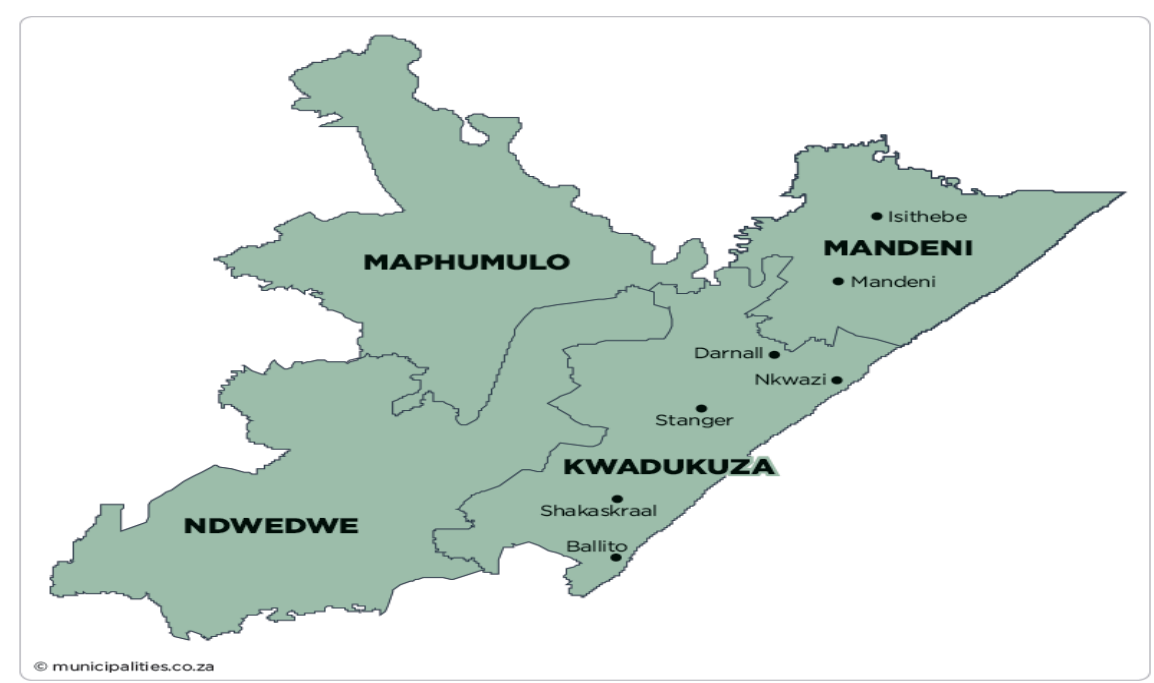
Figure 2. Geographical map representing iLembe district, KwaZulu-Natal. Source: https://municipalities.co.za/map/117/ilembe-district-municipality (accessed on 1 November 2020) [19].